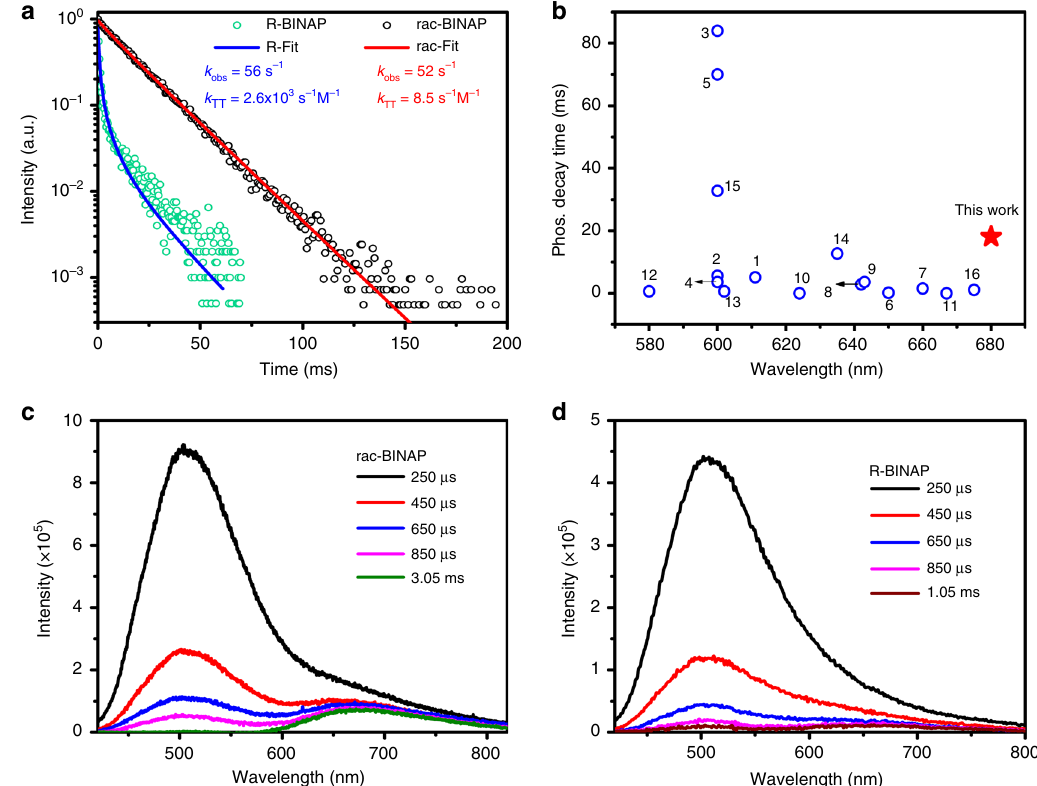
Fig. 3 Time-dependently photophysical properties of BINAP. a The decay dynamics for the RTP in single crystal of rac- BINAP and R- BINAP . The rate constants k obs and k TT (red for rac- BINAP and blue for R- BINAP ) are deduced from the data fi t with Eq. (1). b The literature reported decay time of orange- red non-metal RTP molecules (for details of each number, please see Supplementary Table 3 and Supplementary Fig. 20) 39 – 46 . Spectral temporal evolution of the PL spectrum for ( c ) rac- BINAP and ( d ) R- BINAP in single crystal measured at variant delayed time with a gate width of 200 μ